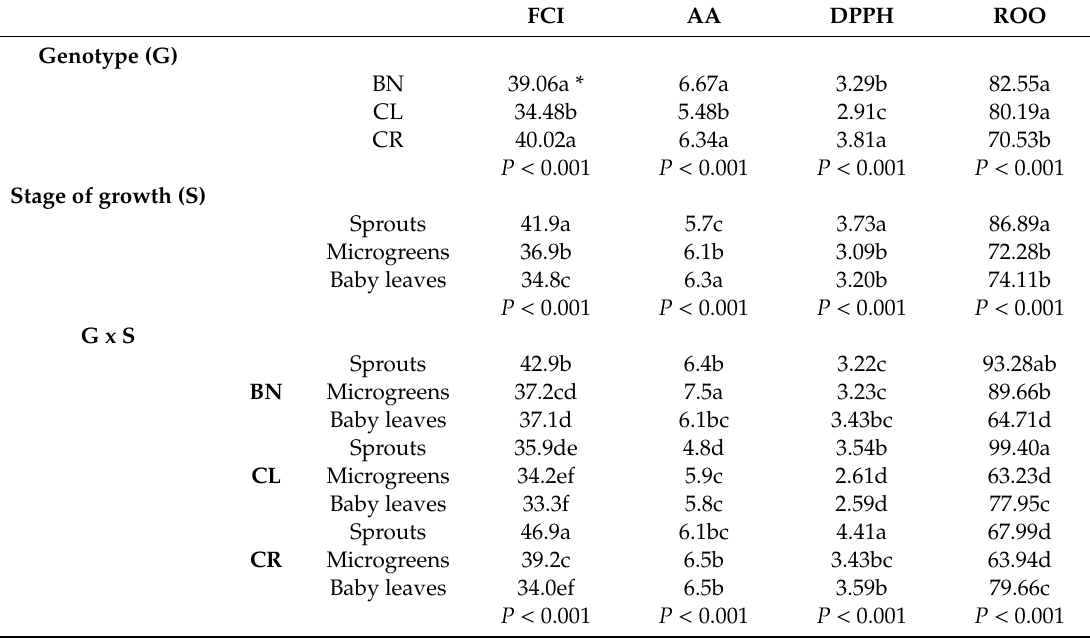
Table 4. Results of the multifactorial ANOVA for Folin–Ciocalteu index (FCI), ascorbic acid (AA), factors “genotype” and “stage of growth” and their